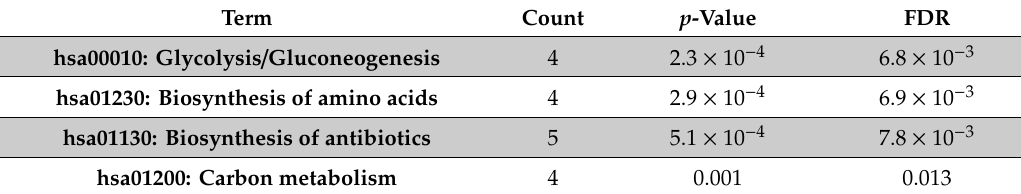
Table 2. KEGG over-representation results. Count: di ff erentially modulated proteins between RAOM and ATH found belonging to the pathway. p -value: The result of the Binomial Test for over-representation. FDR: False Discovery Rate, corrected over-representation probability.